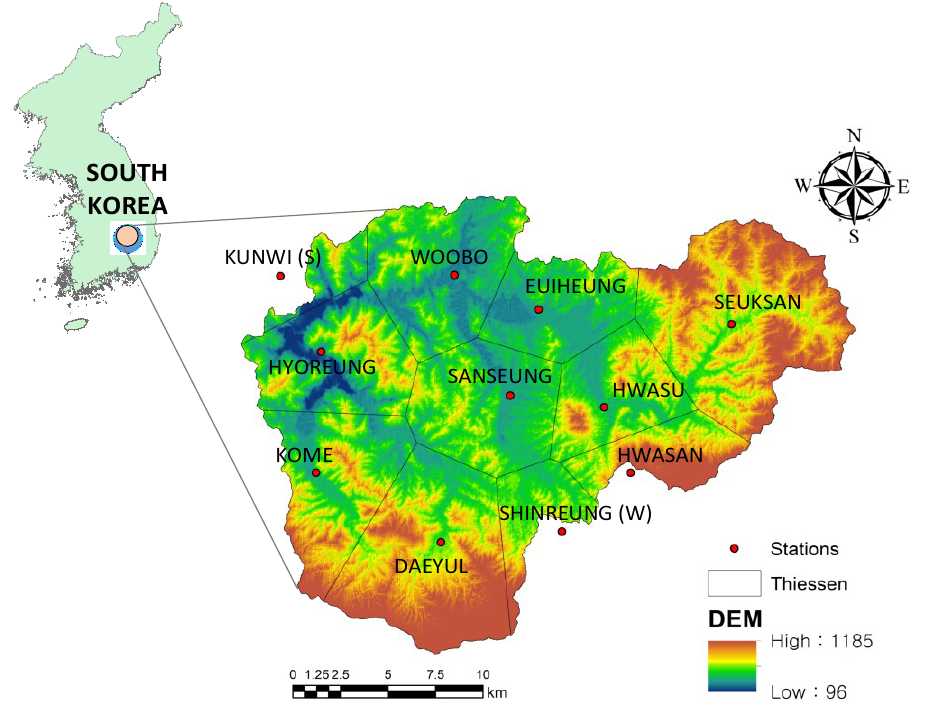
Figure 1. Schematic diagram of the Wi-stream